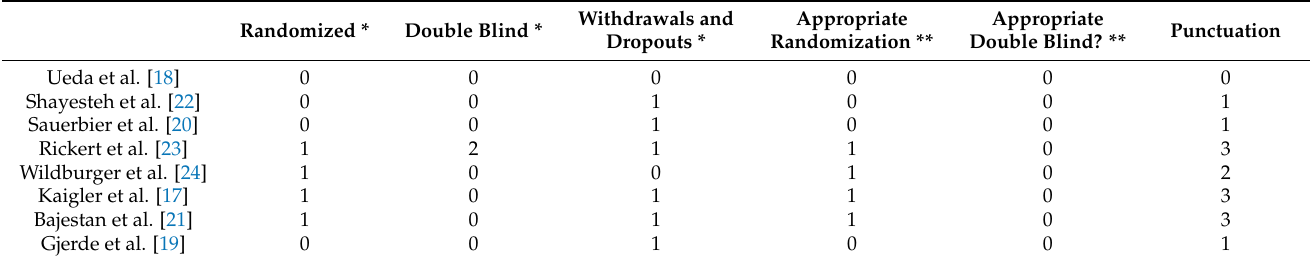
Table 1. Quality evaluation of articles according to the Jadad scale [14].